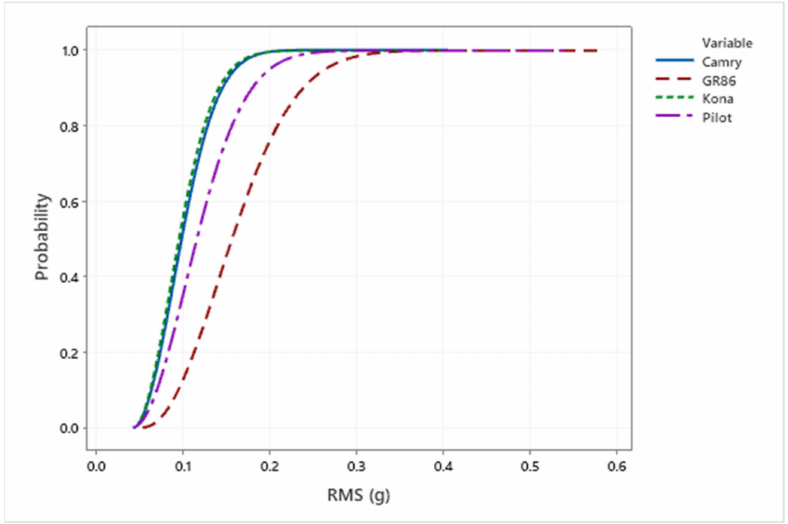
Figure 9. Cumulative distribution function on RMS acceleration in the vertical direction.